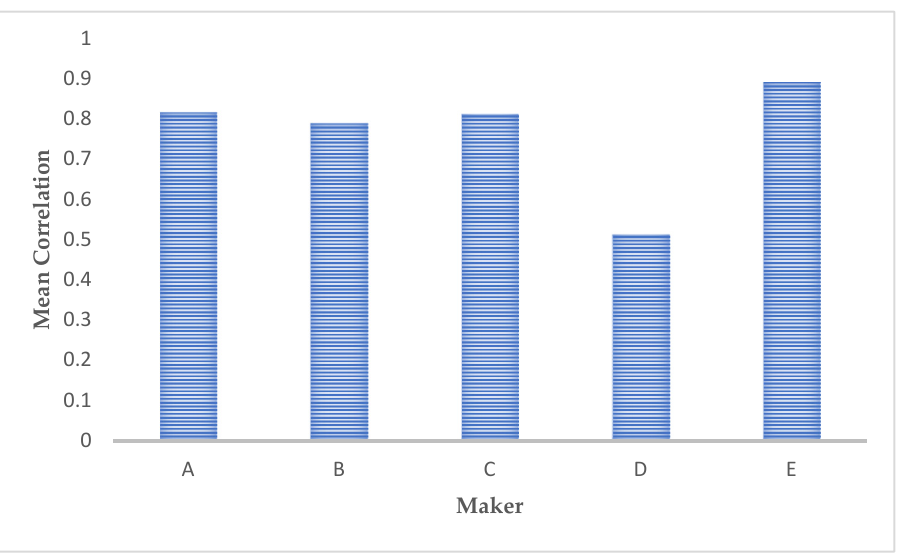
Figure 11. Comparison of the correlation values presented by the different microstructure images.